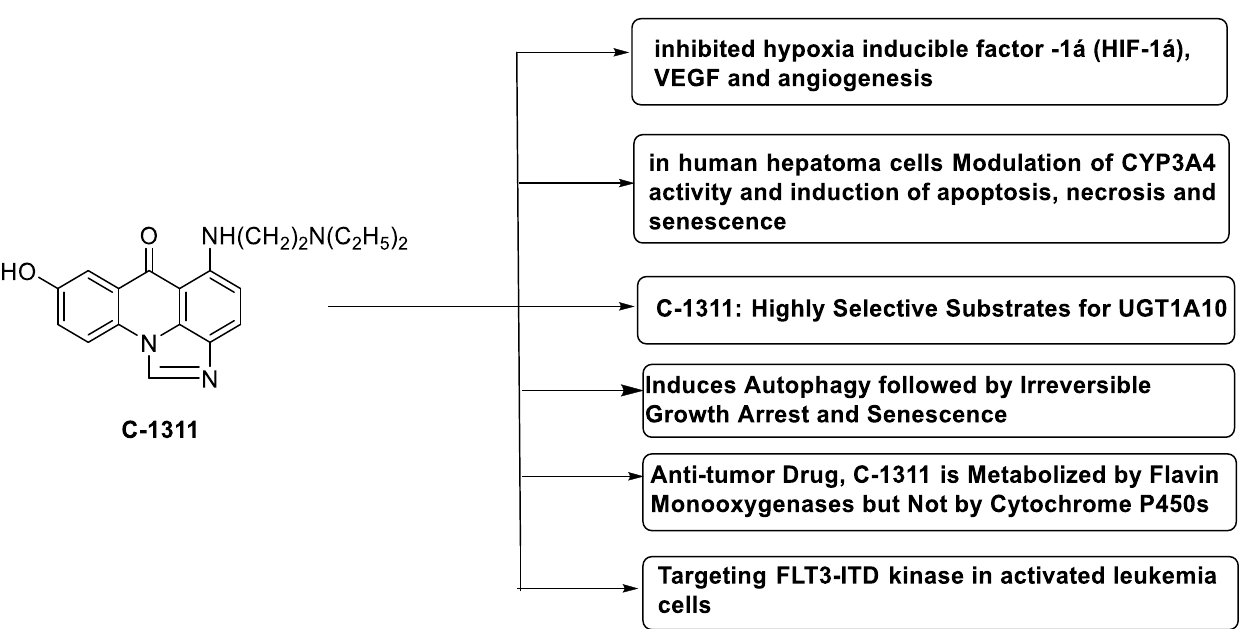
Figure 7. Schematic diagram of C-1311 and its activity.